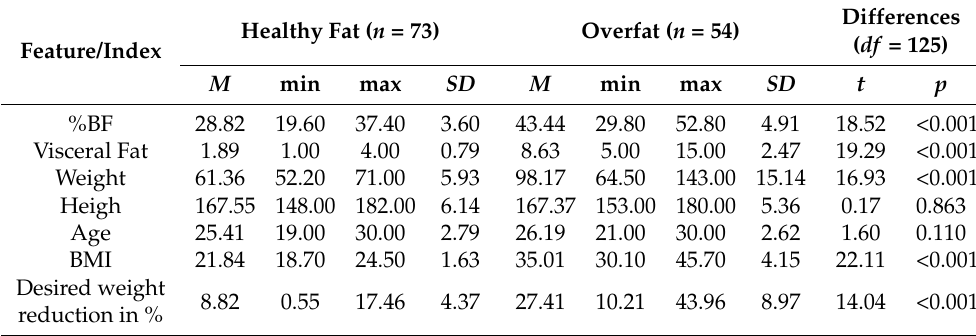
Table 1. Descriptive statistics and differences between